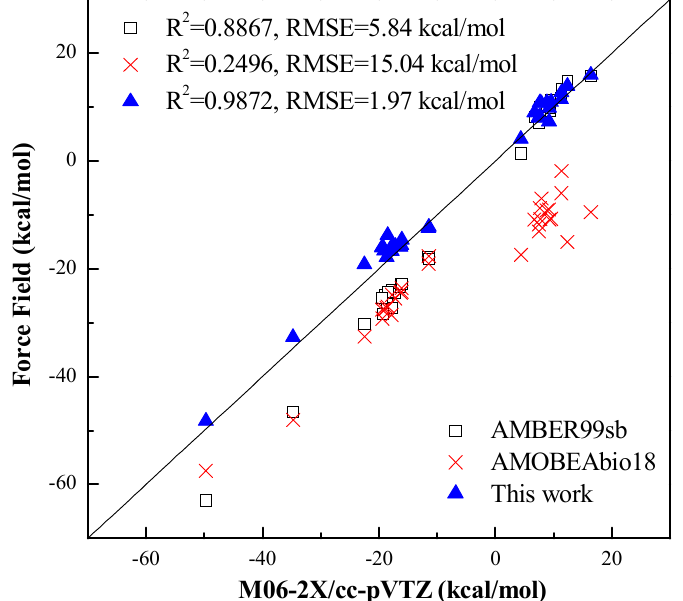
Figure 4. The linear correlation between the M06 − 2X conformational energies and the force field ones.